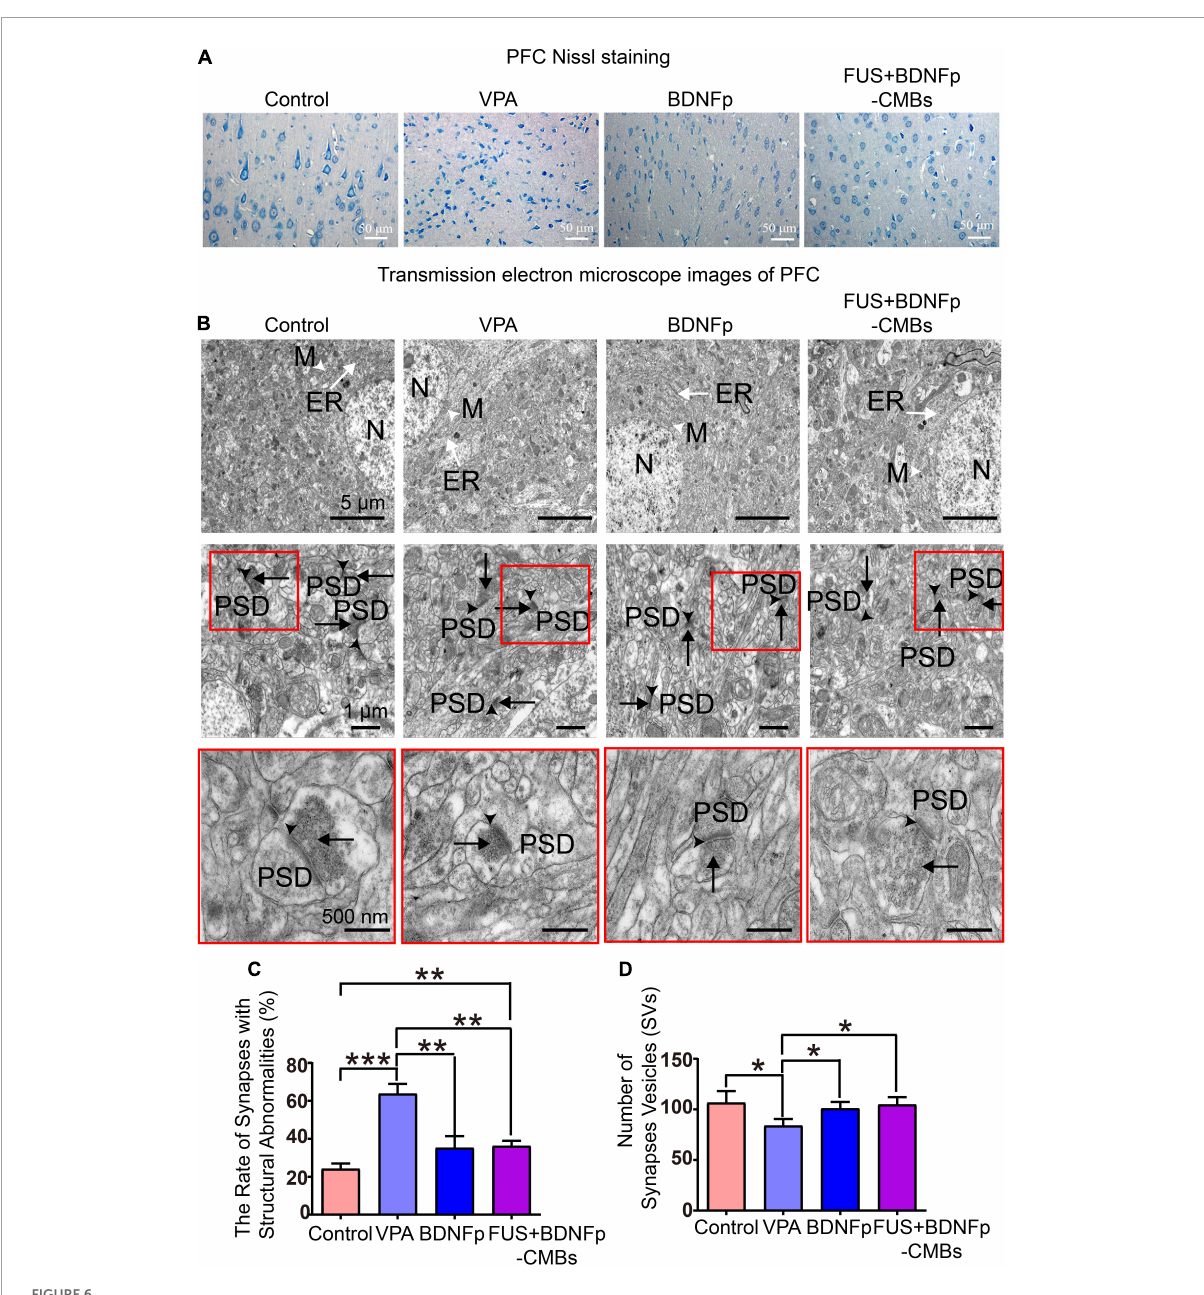
FIGURE6 Pathological observation of autistic rats treated with FUS combined with BDNFp-CMBs. (A) Ordinary light microscopy of PFC Nissl staining of rats in each group (scale: 50 µ m). (B) Transmission electron microscopy of the PFC of rats in each group (White tailless arrow: M, mitochondria. White long-tail arrow: ER, endoplasmic reticulum. Black tailless arrow: SC, synaptic cleft. Black long-tail arrow: SVs, Synaptic vesicles. PSD: postsynaptic density). (C) The ratio of the number of damaged synapses in the PFC to the total number of synapses in each group. (D) The number of SVs in the PFC of rats in each group. Con, Control group; VPA, Autism rat model group; BDNFp, Direct injection of the BDNFp group; FUS + BDNFp-CMBs, FUS combined with the BDNFp-CMBs group, * P < 0.05, ** P < 0.01, *** P < 0.001.